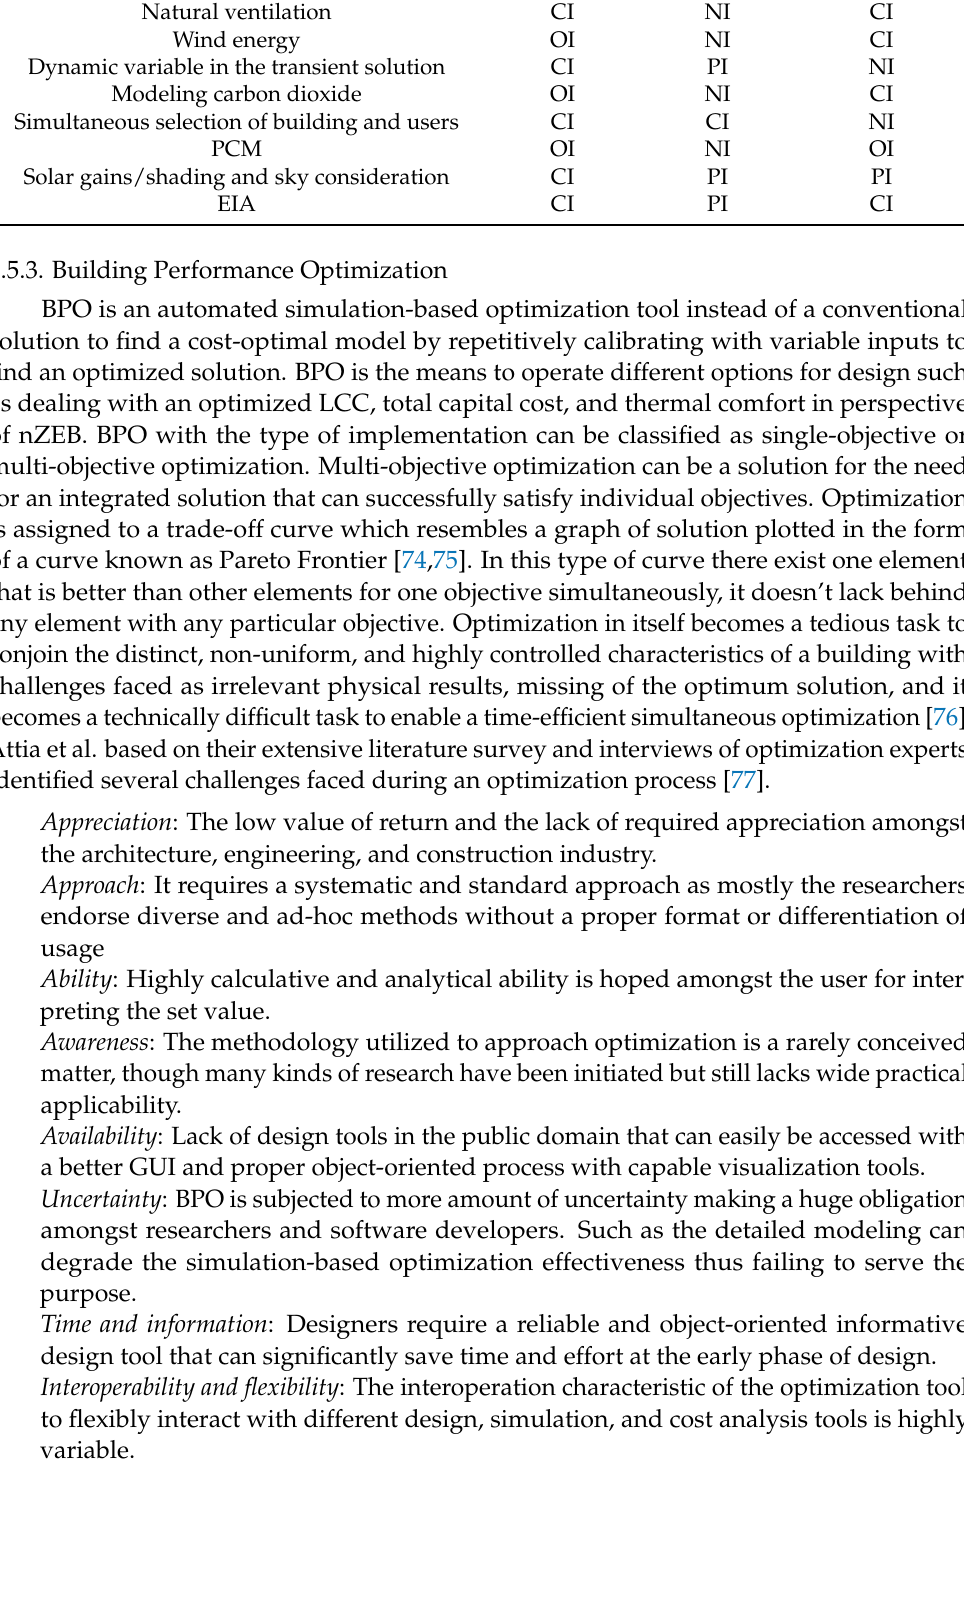
Table 1. Software comparison based on different parameters applicability [50,68–73]. Parameters Trnsys ESP-r Energy Plus Simulation solution Multi-zone simulation Incorporating other tools (MATLAB, CFD, EES) OI Open-source code Ability to add mathematical submodel